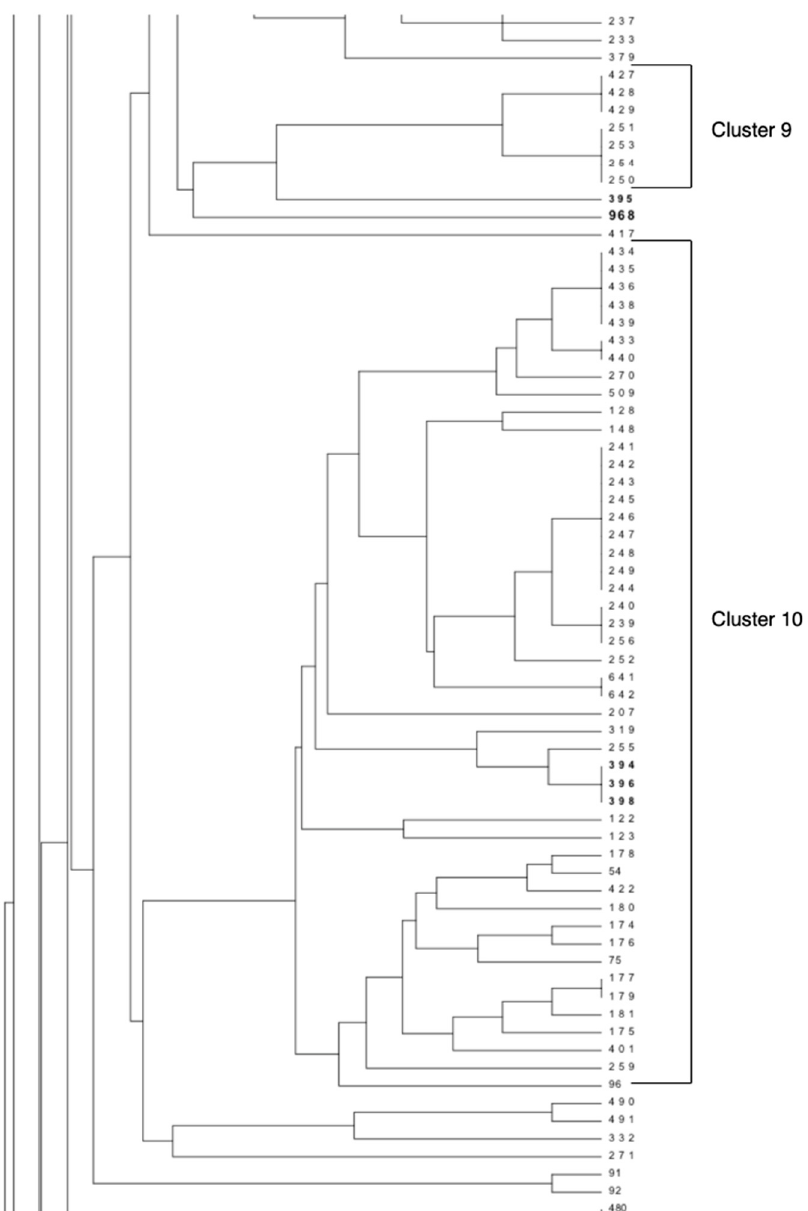
Figure 1. Particulars of the multiple-locus variable number of tandem repeat analysis (MLVA) dendrogram of C. botulinum group I strains circulating in Italy. The figure shows the MLVA clusters 9 and 10 and strain No. 968 (reported in bold) isolated from the feces of the donkey mare affected by botulism. The C. botulinum type A No. 395 was isolated from soil collected from the paddock in which the foals affected by botulism lived (Italy). The other strains reported in bold (Nos. 394, 396, 398) were C. botulinum type B isolated from gastric contents of three foals affected by botulism [8].